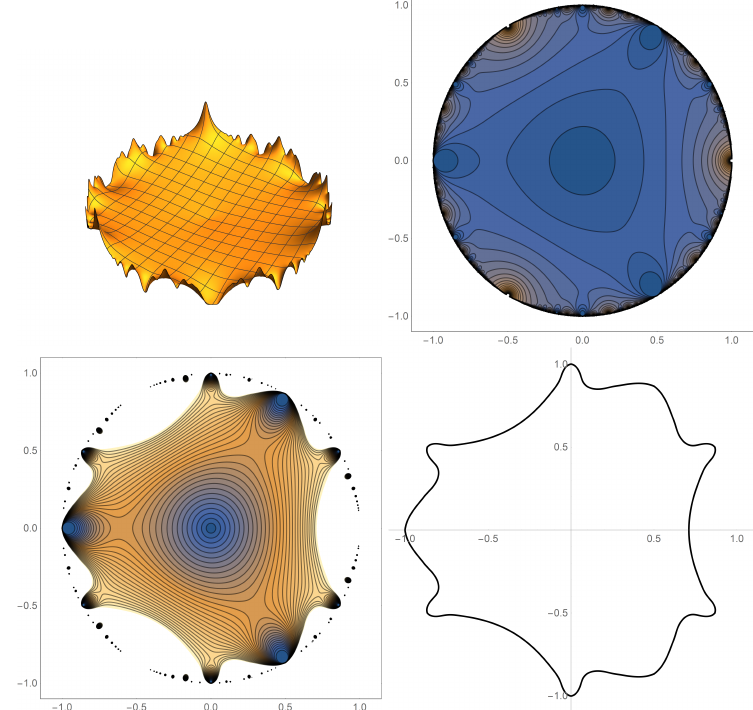
Figure 1. Important ways to present graphs illustrated by the example of L ( C ( 3 ) ; z ) . The top row is a surface and contour plot of | f 32 ( z ) | . The surface is plotted out to ρ = 0.95 in order to give a good view of the surface structure as it approached the natural boundary. For larger values of ρ the singularities of the natural boundary dominate the graph and obstruct the view. The bottom row representations are particularly useful for this work. The contour plot is truncated at the unity level set and shown on the left and only the main contour of the unity level set is shown on the right. For the contour plots, blue shading represents low values and orange shading represents high